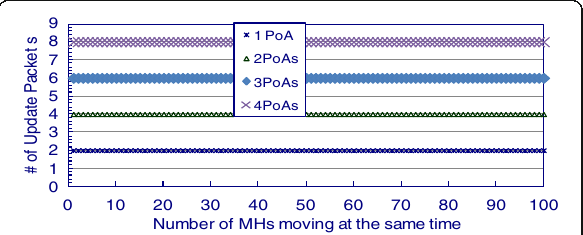
Fig. 16 Signaling overhead for many MHs attach at the same time to the same N-PoA but coming from different PoAs using